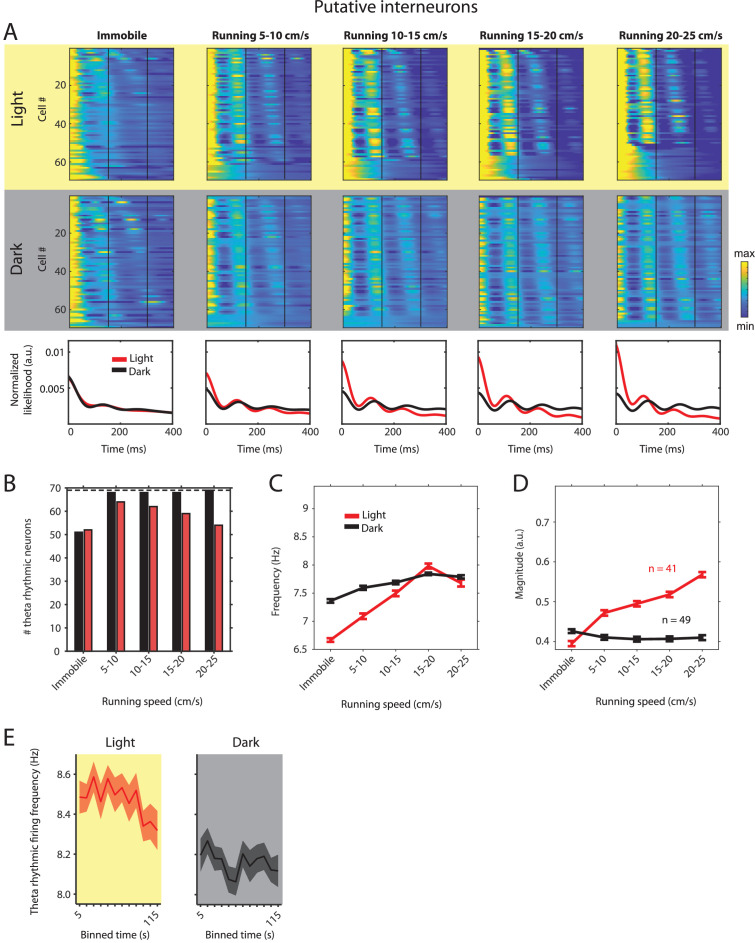
Theta rhythmic firing as a function of running speed and visual inputs in putative interneurons.Red color or yellow background indicates data on the light condition, black and gray color or gray background indicates data on the dark condition. (A) Upper panels show the color coded MLE autocorrelogram models for each of the n = 69 putative interneurons at different running speed intervals. Immobility was defined as running speed <3 cm/s. Neurons are sorted per condition in order of their theta rhythmic firing frequency. Bottom row shows the average across autocorrelogram models per condition. Note that higher synchrony across neurons results in higher rhythmicity magnitude in the average across neurons. (B) Number of neurons shown in A with statistically significant spiking rhythmicity at alpha = 0.1 determined by the MLE model for different running speeds in light and dark. (C, D) Longitudinal analysis of frequency (C) and magnitude (D) of theta rhythmic firing of neurons with significant theta rhythmic firing across all running speed bins (light: n = 41 neurons; dark: n = 49 neurons). Data show mean ± s.e.m. (E) Theta rhythmic firing frequency plotted for consecutive 10 s time bins after the start of light and dark conditions. Theta rhythmic firing frequency was negatively correlated with time after start of light (p=0.0008) or dark (p=0.0452) conditions.